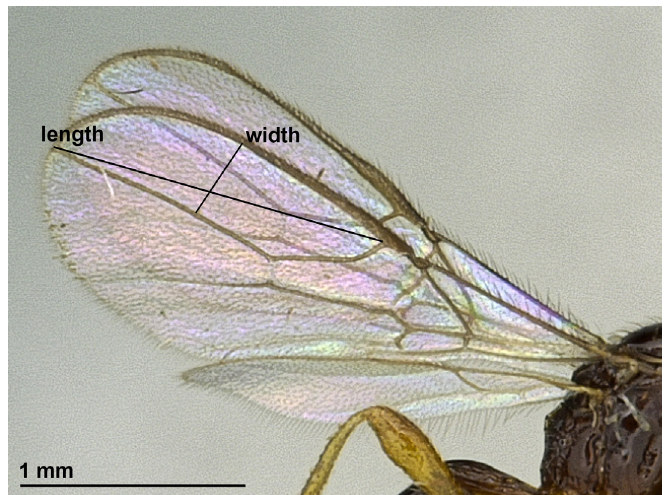
Fig. 1. Marginal cell of fore wing,